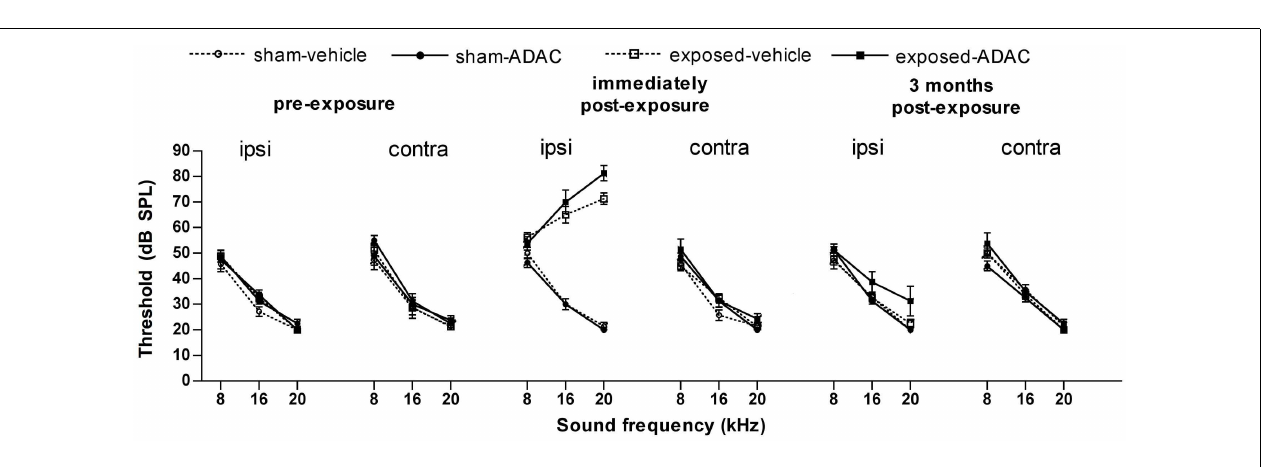
control animals before and after exposure, as a function of intensity in dB SPL and frequency in kHz. Bars represent means ± 1 SE.The drug being tested in this study was ADAC, an adenosine amine congener (Zheng et al., unpublished